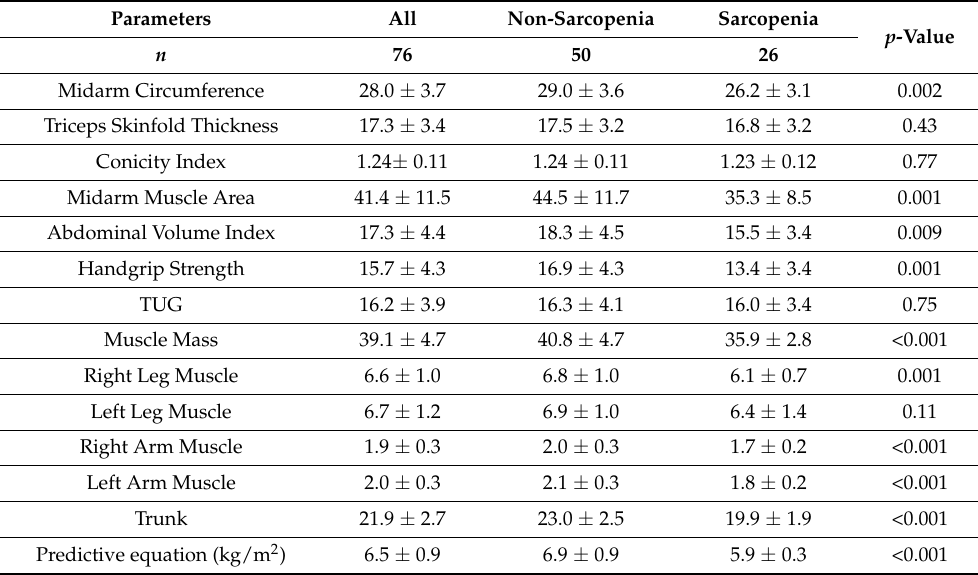
Table 3. Muscle mass, strength, and performance according to sarcopenia